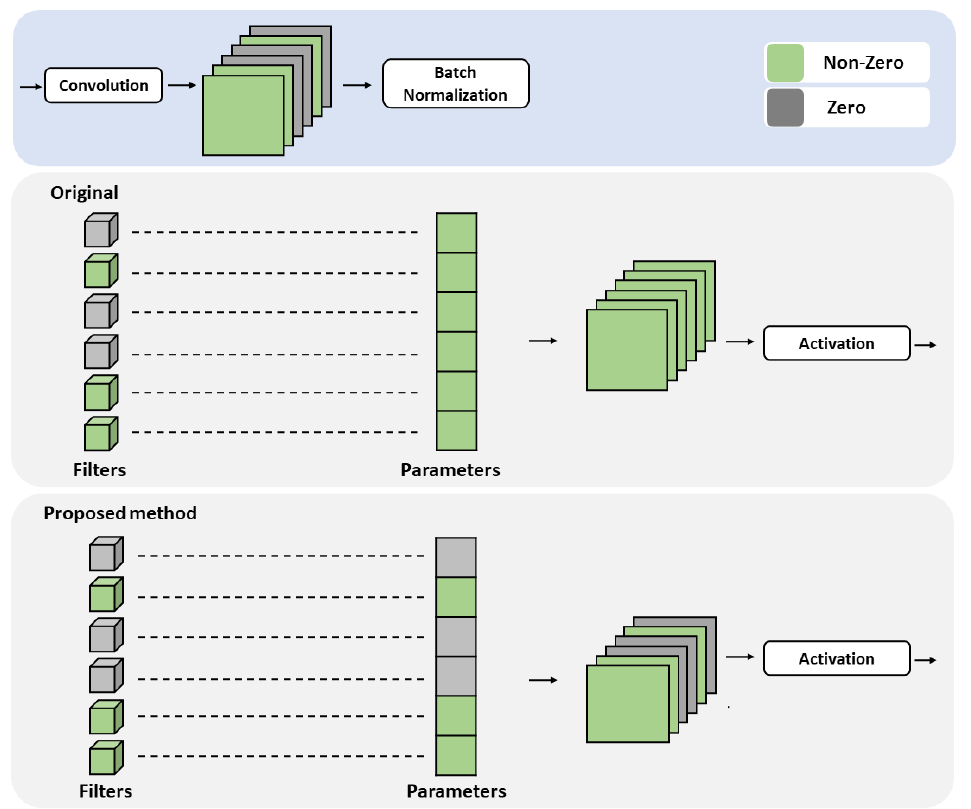
Figure 4. Comparison of different methods for dealing with the batch normalization parameters. Gray and green indicate zero and non-zero values, respectively. The proposed method prunes the batch normalization parameters to correspond with the pruned filters in the convolution layer.